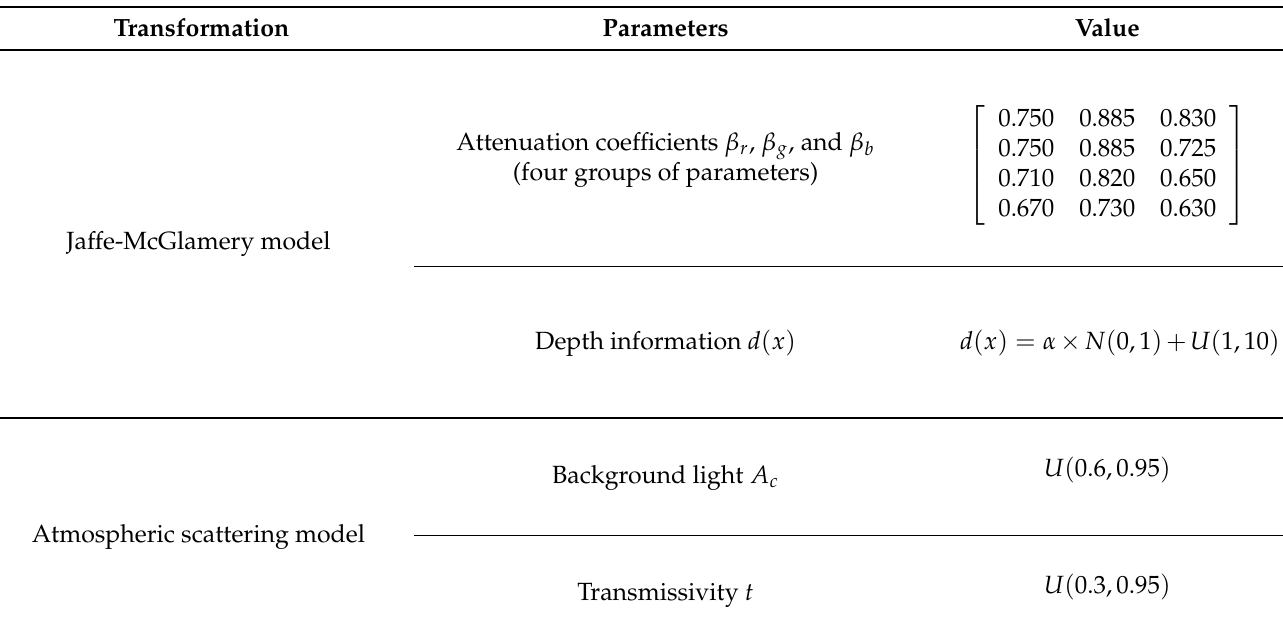
Table 1. The underwater degradation pipeline